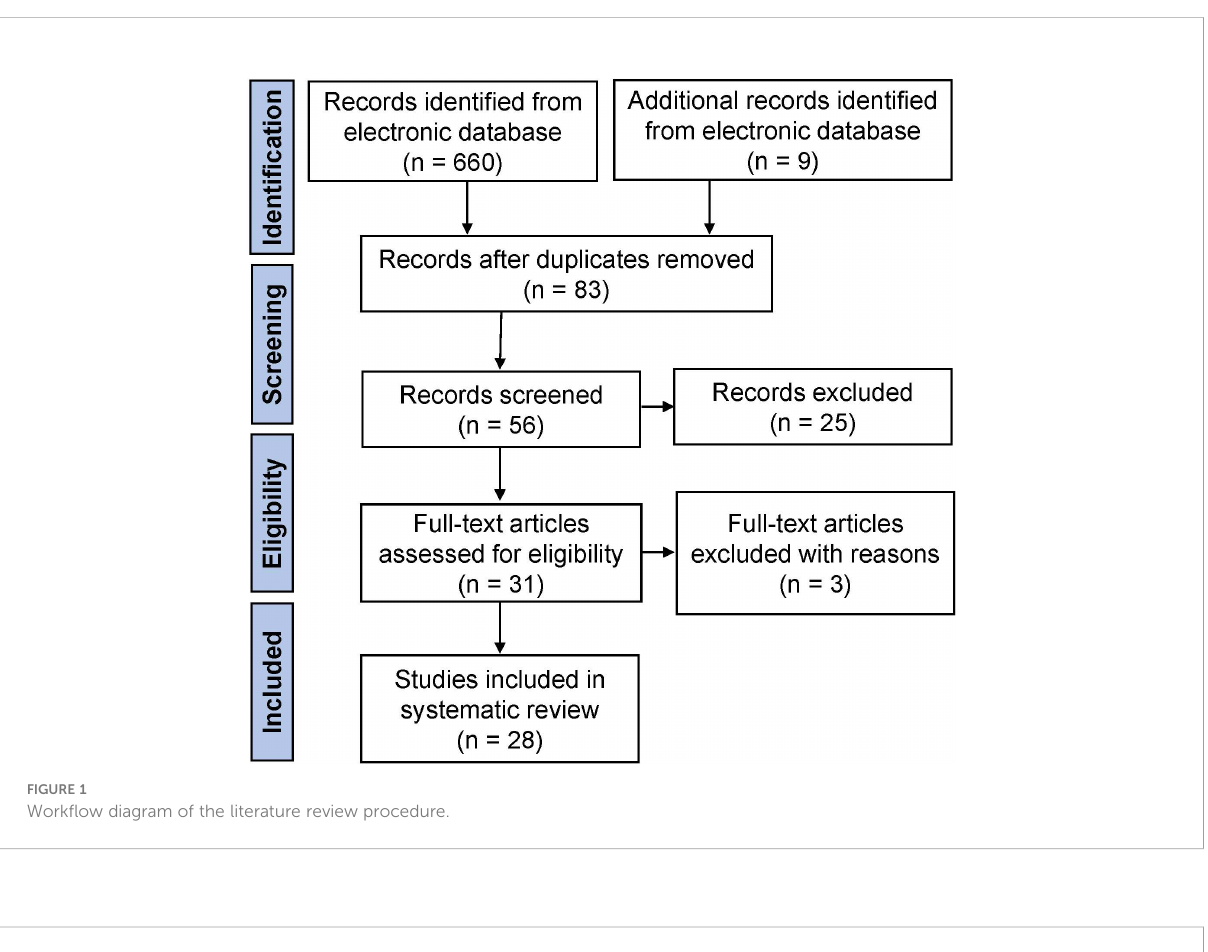
phenotypes were summarized in Table 3.